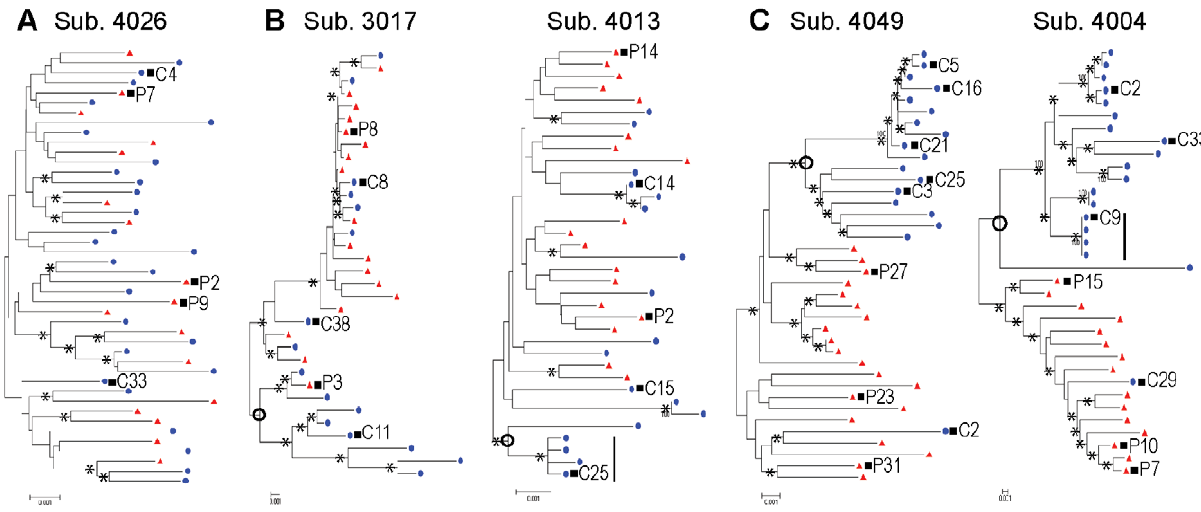
Figure 1. HIV-1 blood and CSF populations in infected children can be well equilibrated, intermediate or compartmentalized. Neighbor-joining phylogenetic trees. env sequences from the CSF are labeled with solid blue circles and env sequences from the blood plasma are labeled with solid red triangles. Bootstrap values $ 40 are indicated ( * ) at the appropriate nodes. Genetic distance is indicated at the bottom of each figure (0.001) and indicates the number of nucleotide substitutions per site between env sequences. Compartmentalized populations are indicated by open circle. Clonal amplification is indicated by solid bar. (a) One representative subject with well equilibrated blood plasma and CSF populations. (b) Two subjects demonstrating an intermediate condition between the blood plasma and CSF viral population. (c) Two subjects demonstrating the presence of a statistically significant compartmentalized population within the CSF relative to the blood, as assessed using the Slatkin-Maddison test